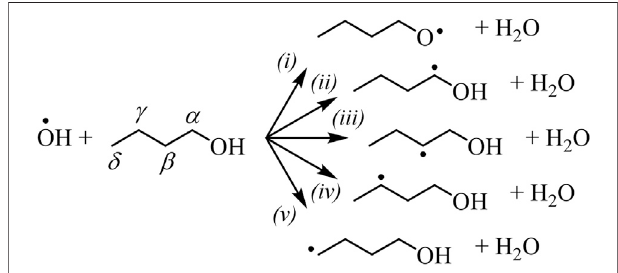
FIGURE 1 | Radicals produced from O ̇ H-initiated H-abstraction from 1- butanol. The – OH functional group predisposes each isomer to undergo a unique set of reactions that compete with chain-branching. Similar effects are created by other oxygenated functional groups.